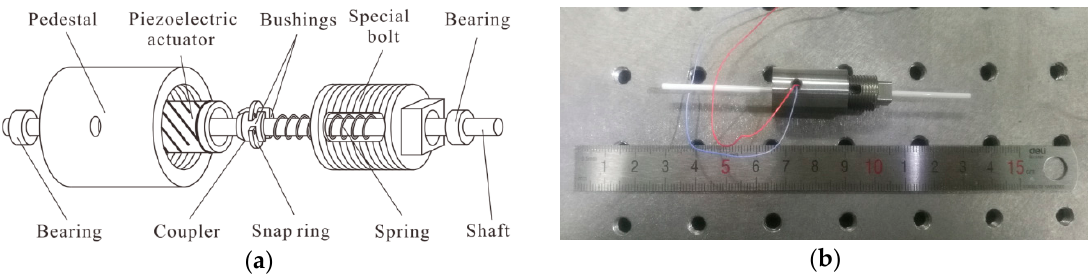
Figure 3. The structure of the piezoelectric motor: ( a ) schematic diagram of the piezoelectric motor; ( b ) photograph of the fabricated prototype motor.